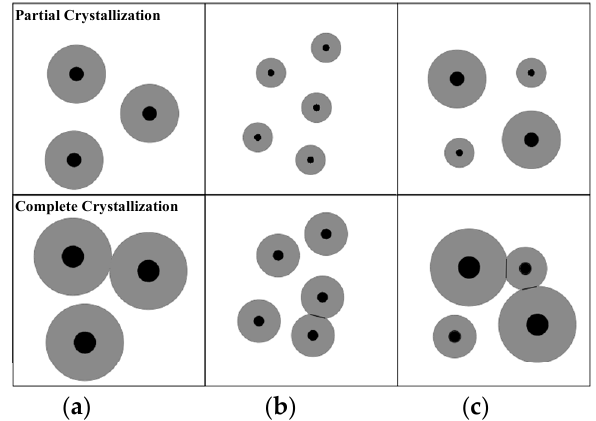
Figure 4. Schematic states of partial and complete crystallization for micro and nano ZnO / LDPE composites: ( a ) M3, ( b ) N3, and ( c ) N2M1.